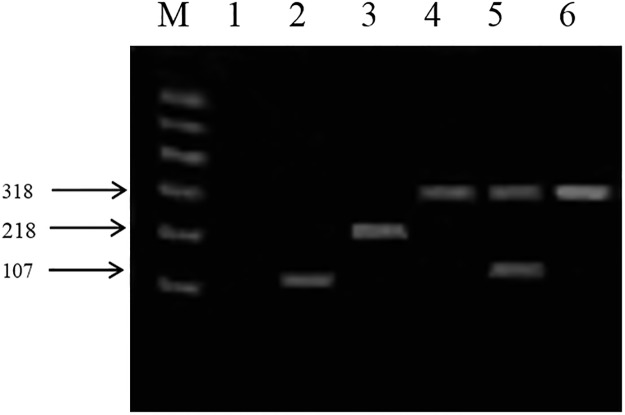
Amplification products obtained from the recA multiplex assay.Lane M contained a 600 bp PLUS DNA ladder (Tiangen Biotech Co, Ltd., Beijing, China). Lanes 1, 2, 3, 4 and 5, PCR amplication products from L. casei JCM 16167T (negative control), L. paraplantarum JCM 12533T, L. pentosus JCM 1558T, L. plantarum subsp. plantarum JCM 1149T and L. plantarum subsp. argentoratensis JCM 16169T, respectively; Lane 6, PCR amplification product from R 422.